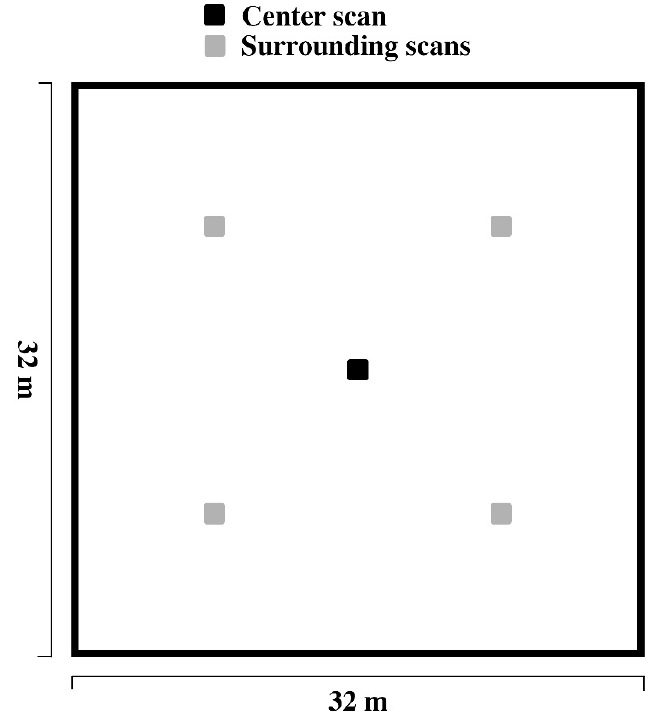
Figure 2. Scan setup with multiple scan positions for terrestrial laser scanning data acquisition from 32 × 32 m sample plots.